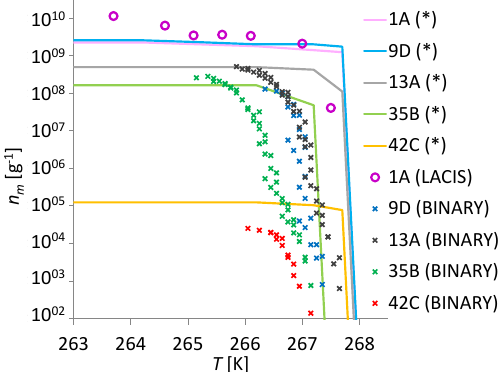
Figure 3. Comparison of ice nucleation curves of 0.1µm filtrates from a few M. alpina strains. The number and letter combination la- bels the strain. The devices used for generating the respective curves are shown in brackets. ∗ stands for the setup described in Fröhlich- Nowoisky et al.